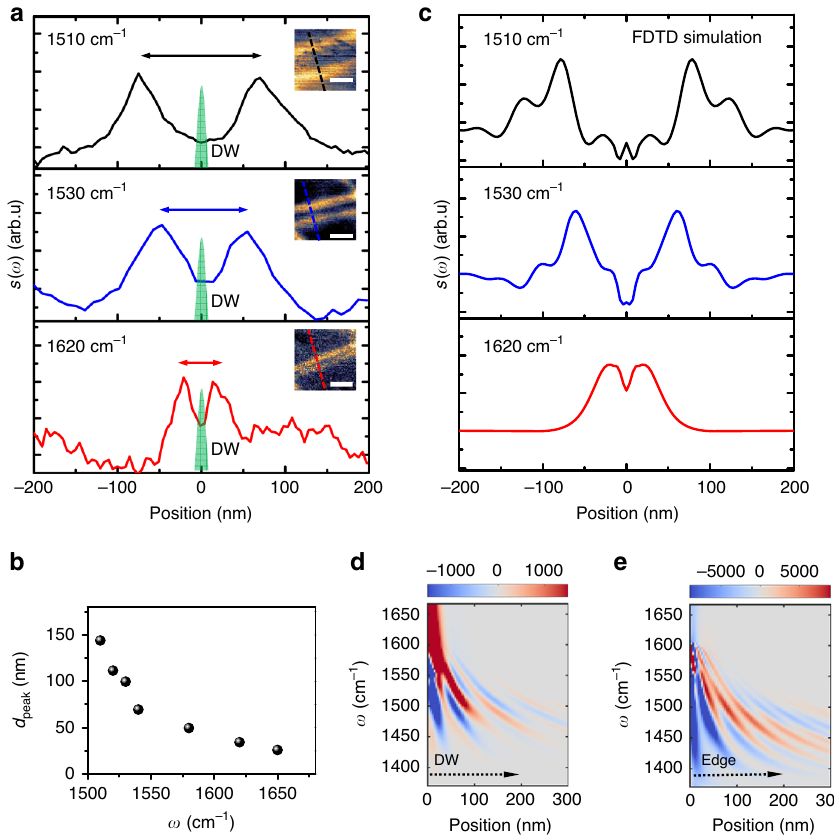
Fig. 4 Phonon polariton re fl ectance at the domain walls in the underlying TBG. a Phonon polariton interference pro fi les across the same domain wall (DW) under excitation frequency ω = 1510 cm − 1 (top panel), ω = 1530 cm − 1 (middle panel) and ω = 1620 cm − 1 (bottom panel). The green shaded areas label the domain wall with width of about 10 nm. The double arrows in the top (black), middle (blue), and bottom (red) indicate the distance between the two symmetric peaks d peak . Insets: Mapping of amplitude s ( ω ) of the domain wall. Dash lines indicate where the pro fi les are taken respectively. Scale bars: 100 nm. b Distance between the two symmetric peaks d peak (black dots) as a function of excitation frequency ω . All data points are extracted at the same domain wall. c FDTD simulations of the phonon polariton interference pro fi les shown in a . d , e Dispersion of the phonon polariton interference pro fi le calculated with FDTD simulations for frequencies ω = 1380 cm − 1 to ω = 1670 cm − 1 while varying positions of the sampling tip with respect to the domain wall ( d ), and the edge of the heterostructure ( e ). The simulated tip scanning directions are indicated by the dashed